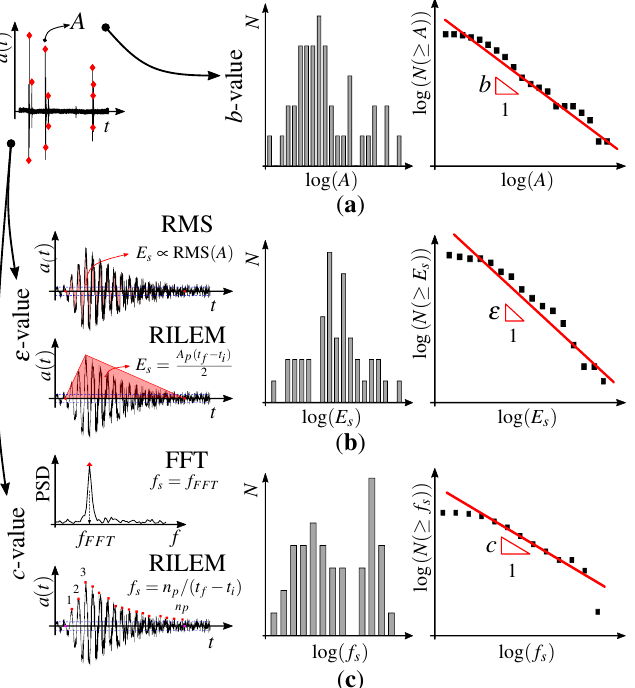
Figure 3. Precursors from AE tests, ( a ) obtaining b from Equation (1); ( b ) calculation of (cid:101) from Equation (2); and, ( c ) determining c from Equation